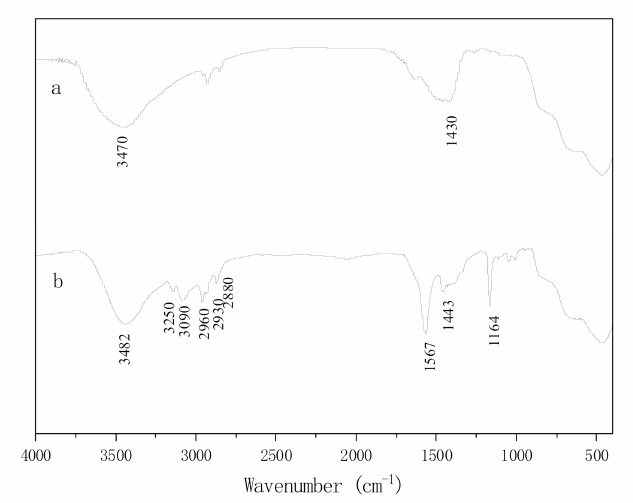
Figure 4. FT-IR spectra of pure hydrotalcites ( a ) and IL-CaMgAl ( b ).